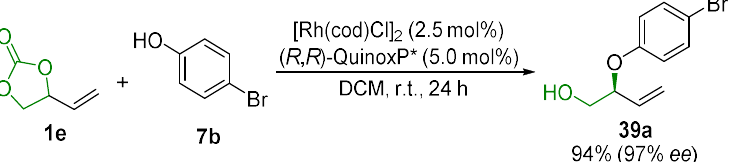
Scheme 24. Conversion of carbonate 1e by asymmetric O -allylation of 4-bromophenol 7b .